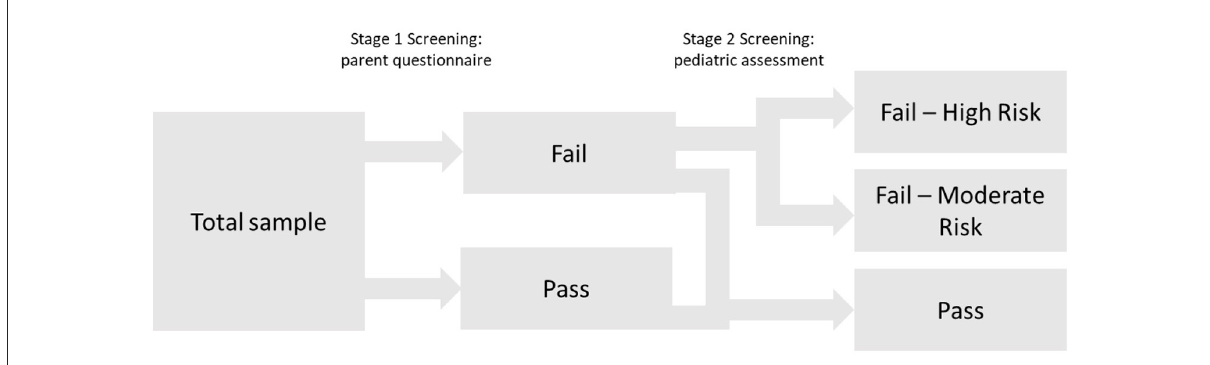
FIGURE1 Conceptual overview of the two-stage screening